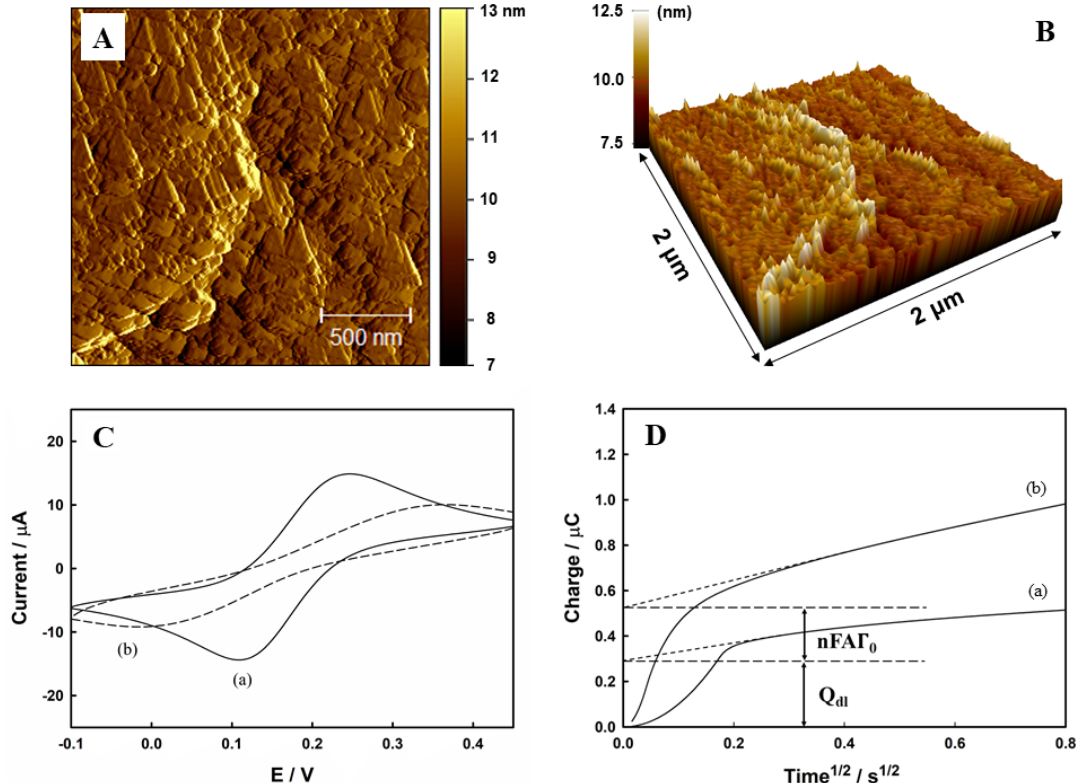
Figure 2. ( A ) 2D and ( B ) 3D AFM images of bare SPCE. ( C ) Cyclic voltammograms of (a) SWCNT − casted SPCE (SWCNT/SPCE) and (b) after being incubated with 50 μ M TBA in a EB